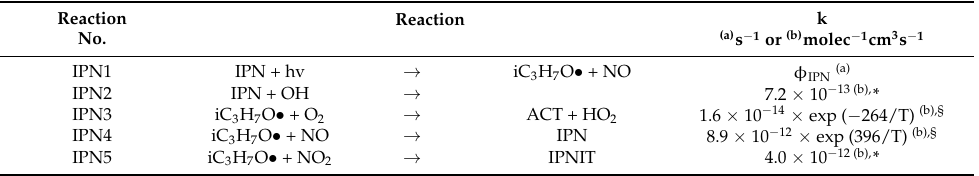
Table 1. IPN chemical reactions.